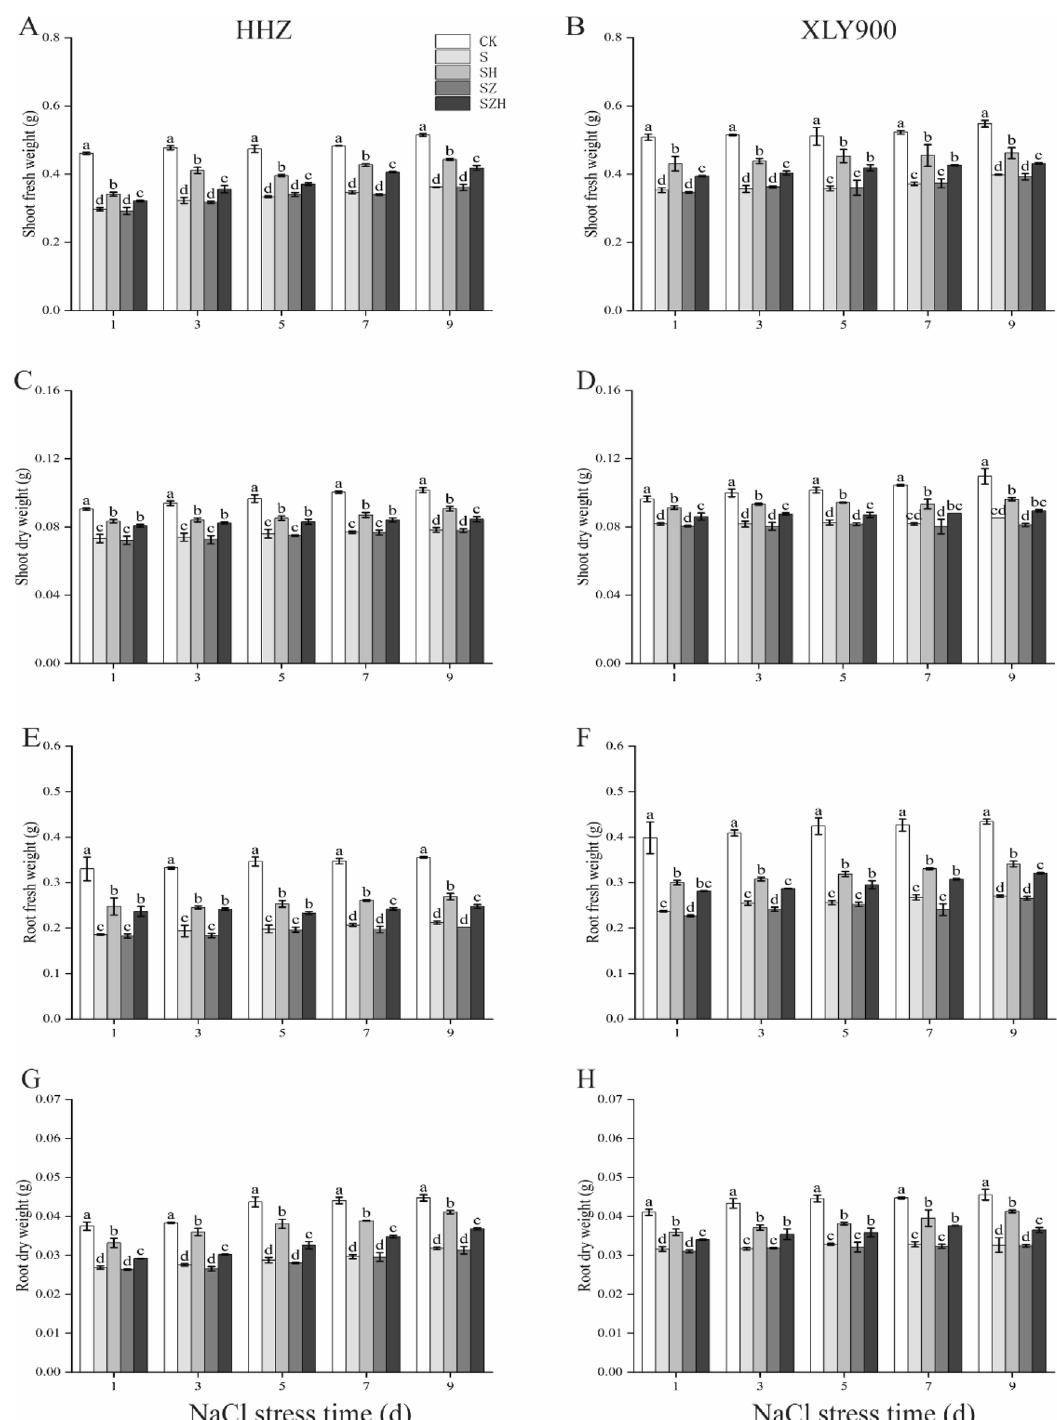
Figure 4. Effect of Hemin on seedling biomass of rice under salt stress. Shoot fresh weight in HHZ ( A ) and XLY900 ( B ); shoot dry weight in HHZ ( C ) and XLY900 ( D ); root fresh weight in HHZ ( E ) and XLY900 ( F ); root dry weight in HHZ ( G ) and XLY900 ( H ). CK: 0 mM NaCl + 0 μmol·L −1 Hemin, S: 50 mM NaCl + 0 μmol·L −1 Hemin, SH: 50 mM NaCl + 5 μmol·L −1 Hemin, SZ: 50 mM NaCl + 25 μmol·L −1 ZnPP, SZH:50 mM NaCl + 5 μmol·L −1 Hemin + 25 μmol·L −1 ZnPP. Values are the mean ± SD of three replicate samples. Different letters in the data column indicate significant differences (p < 0.05) according to Duncan’s